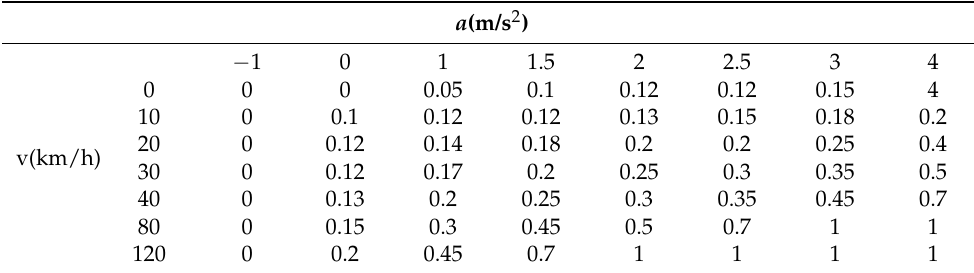
Table 3. Two dimensional relationships of inverse engine model.